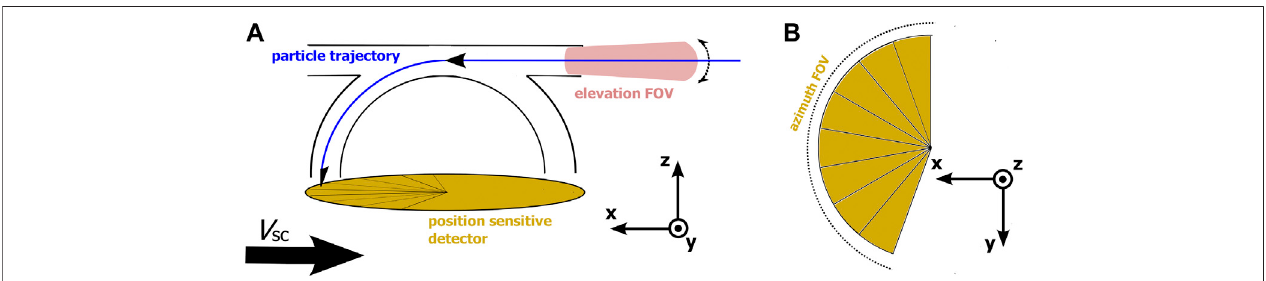
FIGURE 1 | Schematic of the concept instrument. (A) The top-hat electrostatic analyzer diagram showing the narrow fi eld of view of the elevation direction, the trajectory of a charged particle through the instrument, and the position sensitive detector. The black arrow on the bottom indicates the spacecraft ’ s velocity direction. (B) View from the top of the eight azimuth anodes which resolve the azimuth direction of the detected